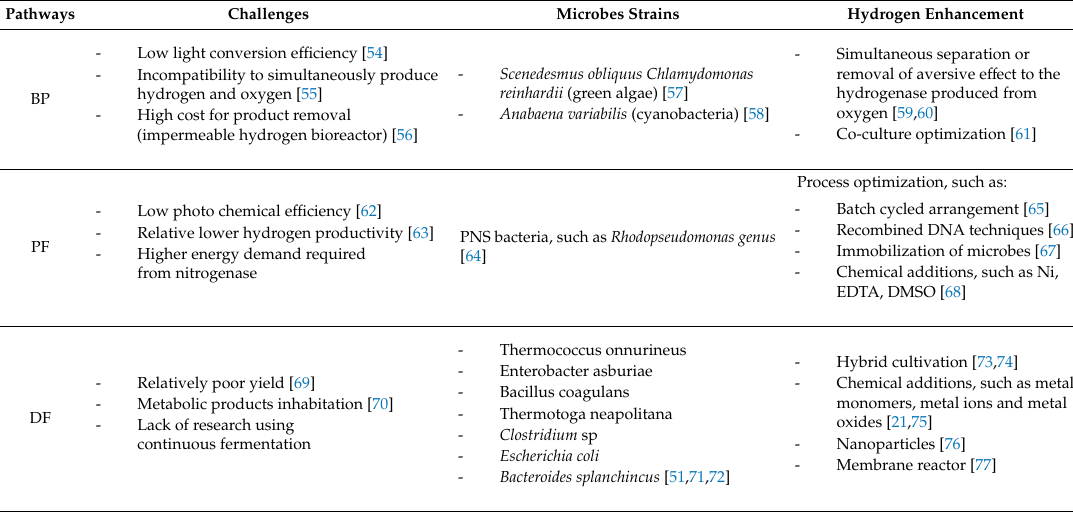
Table 1. Summary of bio-hydrogen pathways catalyzed by